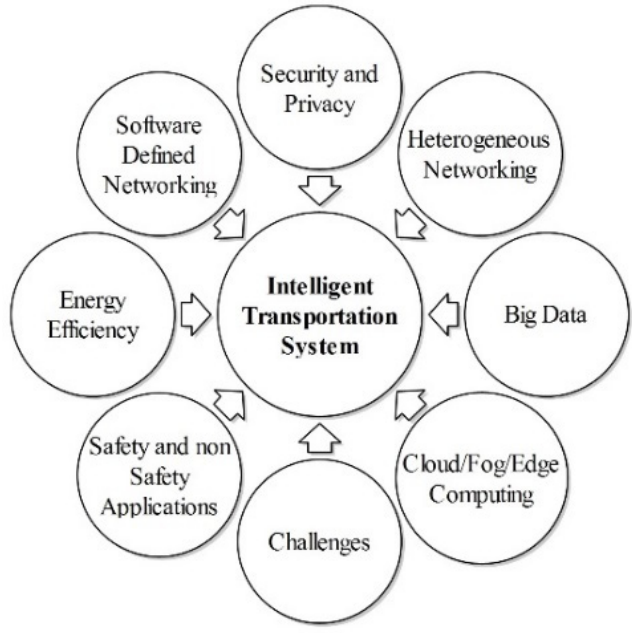
Figure 5. Integration of intelligent transportation system with SDNs and the other technologies.